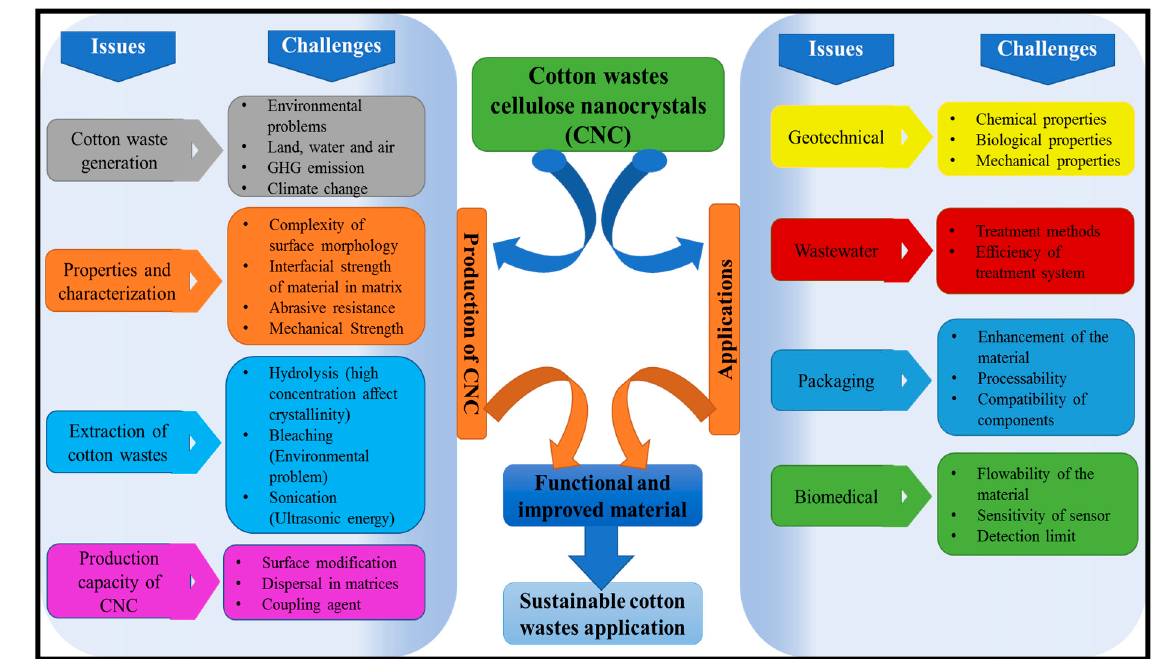
Figure 14. Issue challenges of extraction methods for the production of CNC.